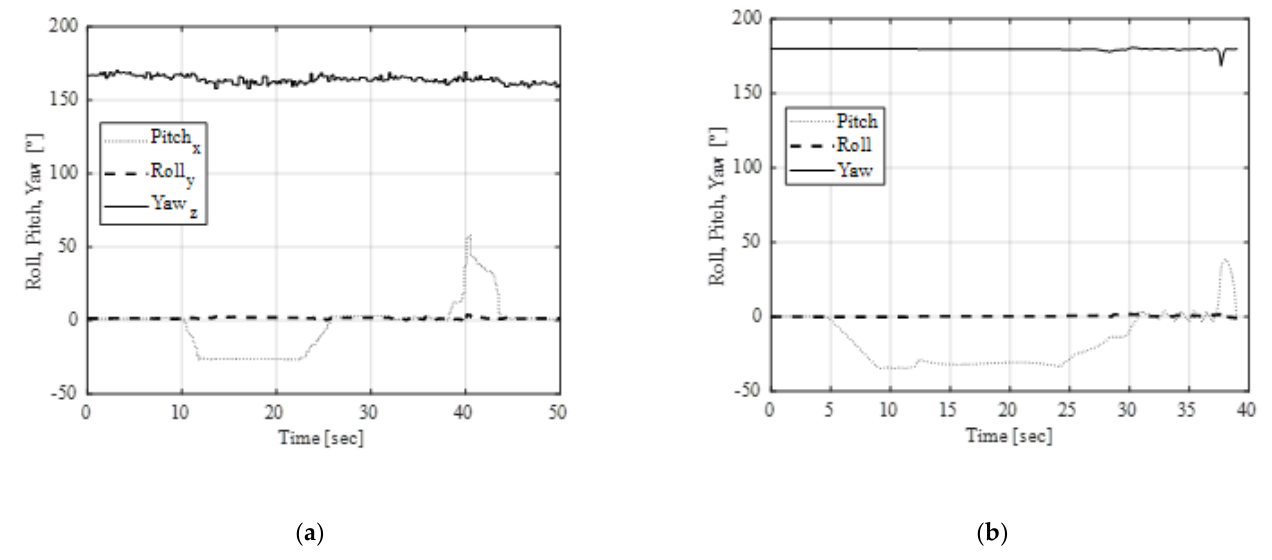
Figure 9. Experimental/numerical test of the dynamic behavior of the robot in Figures 6 and 7 in negotiating with the stepfield pallet: Roll, pitch and yaw ( a ) experimental and ( b ) numerical results.